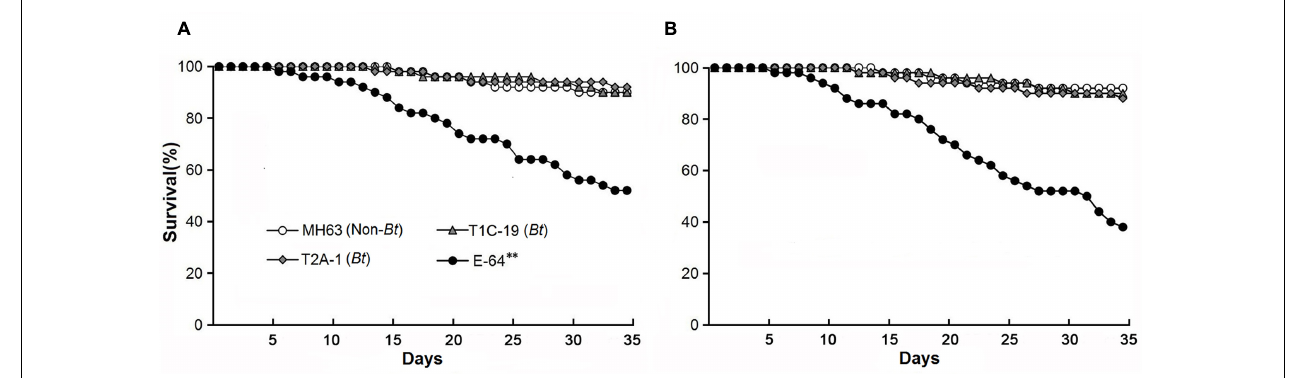
FIGURE 1 | Survival of Folsomia candida on a diet consisting of rice pollen (A) or a mixture of rice leaf powder and baker’s yeast (10:1) (B) . The pollen and leaf power were obtained from either of two Bt rice lines (T1C-19: Cry1C, and T2A-1: Cry2A) or their non- Bt near isoline MH63 (negative control). For the positive control, the corresponding non- Bt rice tissue was supplemented with E-64. Asterisks indicate a significant difference between the treatment and the negative control (Logrank test, P < 0.01) ( n =